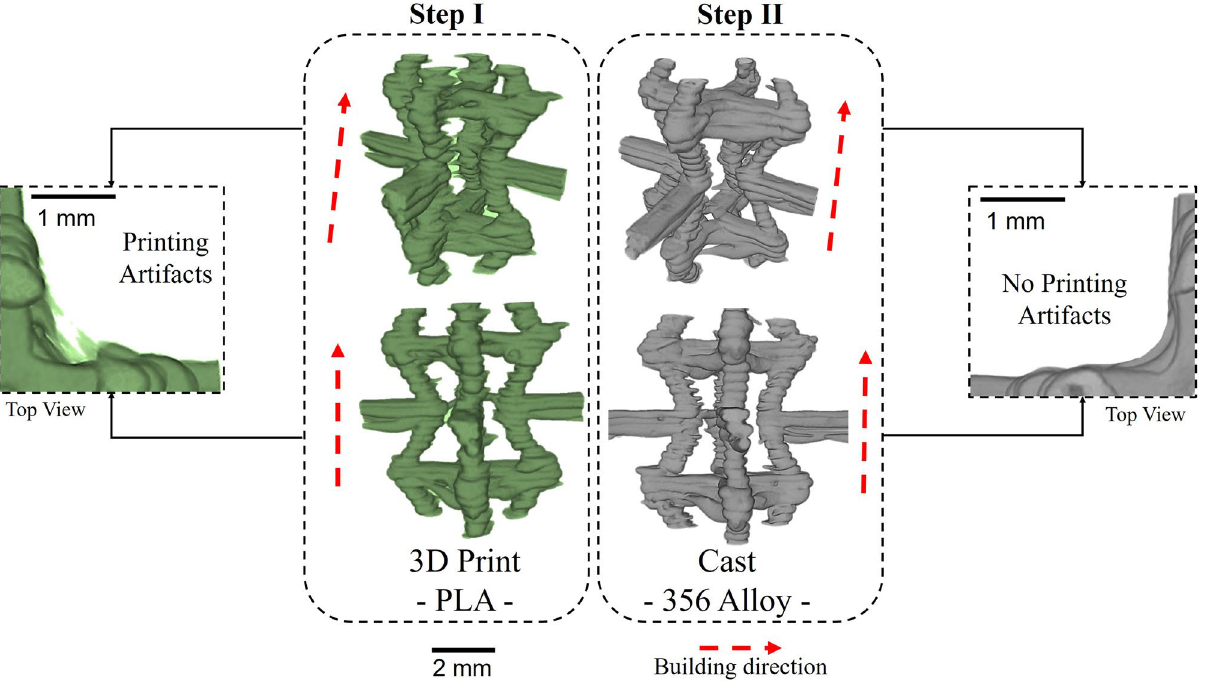
Figure 2. Regions of interest from the µCT renderings (Avizo Standard segmentation) for the periodic cell during the two steps in the manufacturing